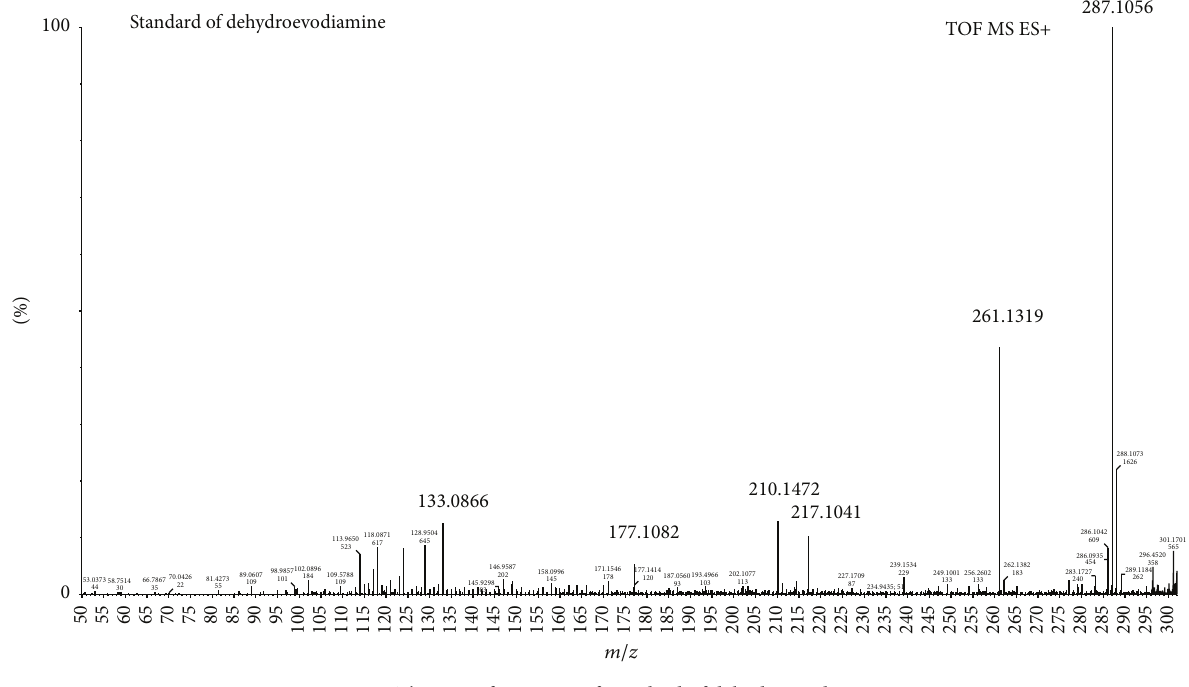
Figure 7: The main fragments of standard of